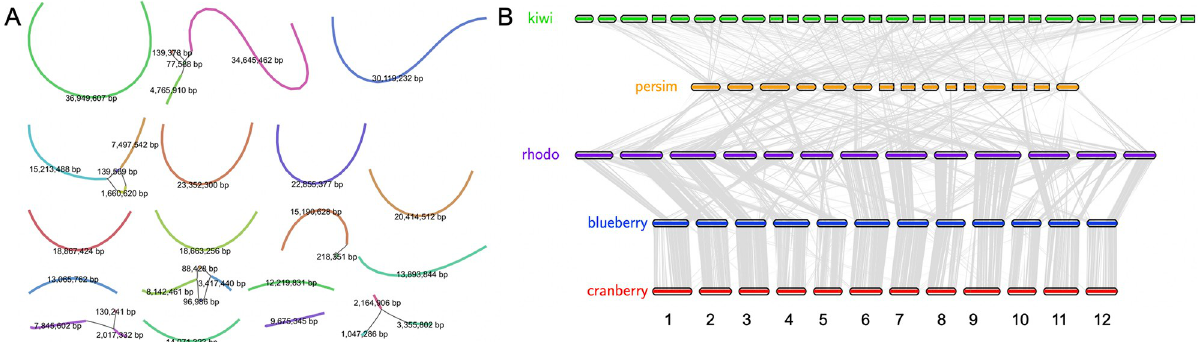
Fig 2. Chromosome scale assembly of Vaccinium macrocarpon (Vmac). A) Genome assembly graph of the cranberry genome resulted in chromosome scale, reference quality, contigs and very few “hairballs” (graph bubbles, or multiple connections due to heterozygosity and repeats). Contig size (bp) labeled, and color is randomly assigned. B) Protein based alignment of the cranberry (red; Vaccinium macrocarpon ) genome with blueberry (blue; Vaccinium corymbosum ), rhododendron (purple; rhodo; Rhododendron williamsianum ), persimmon (orange; persim; Diospyros lotus ), and kiwi (green; Actinidia chinensis ). Lines (grey) symbolize pairwise syntenic blocks between